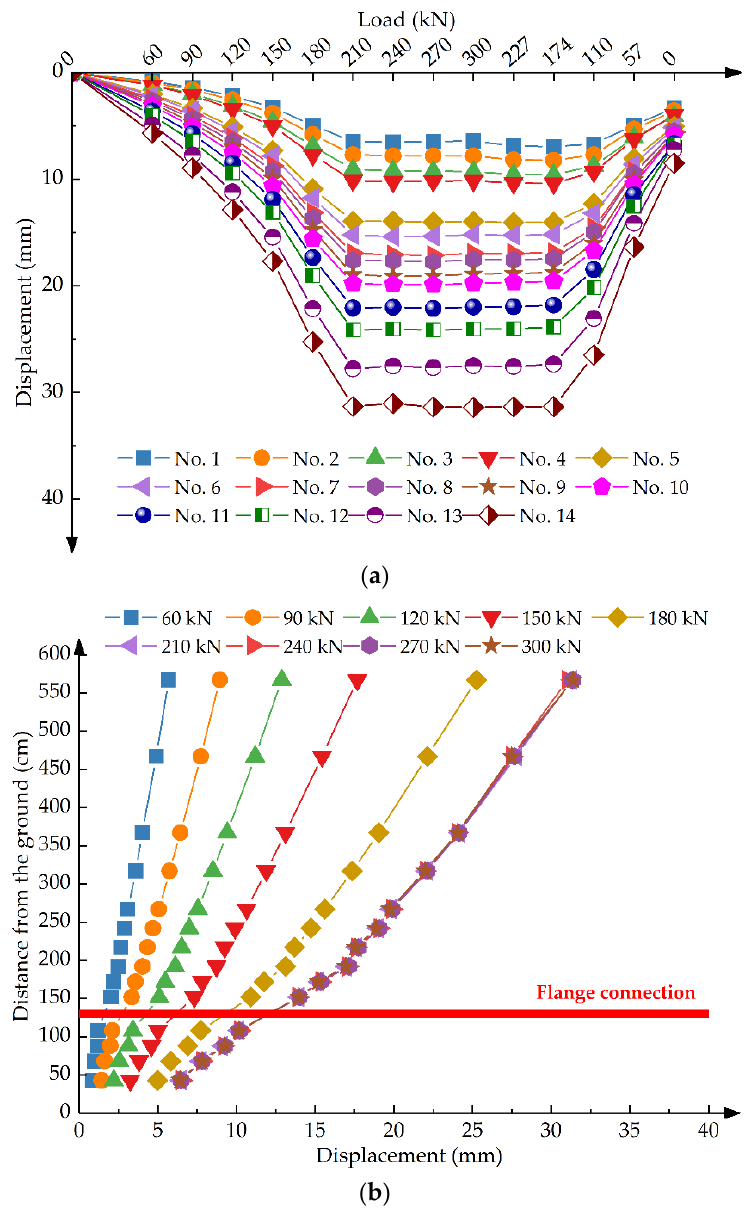
Figure 13. Displacement test results of single pile No. 5: ( a ) displacement–load curve of each transverse displacement measuring point and ( b ) displacement curves under various loads.